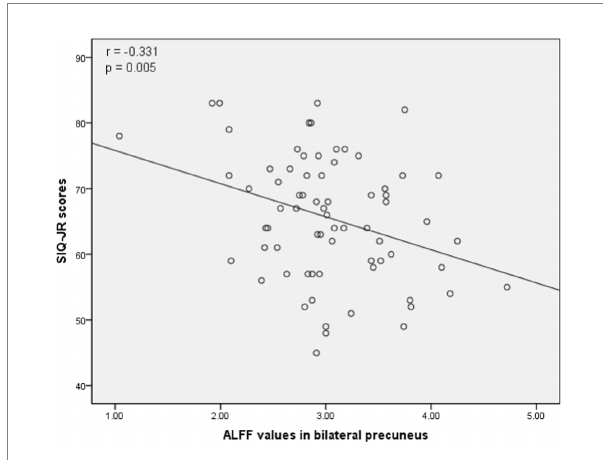
FIGURE 4 Correlations between abnormal ALFF and Suicidal Ideation Questionnaire Junior (SIQ-JR) scores. A negative correlation was found between the ALFF values in the bilateral precuneus and SIQ- JR